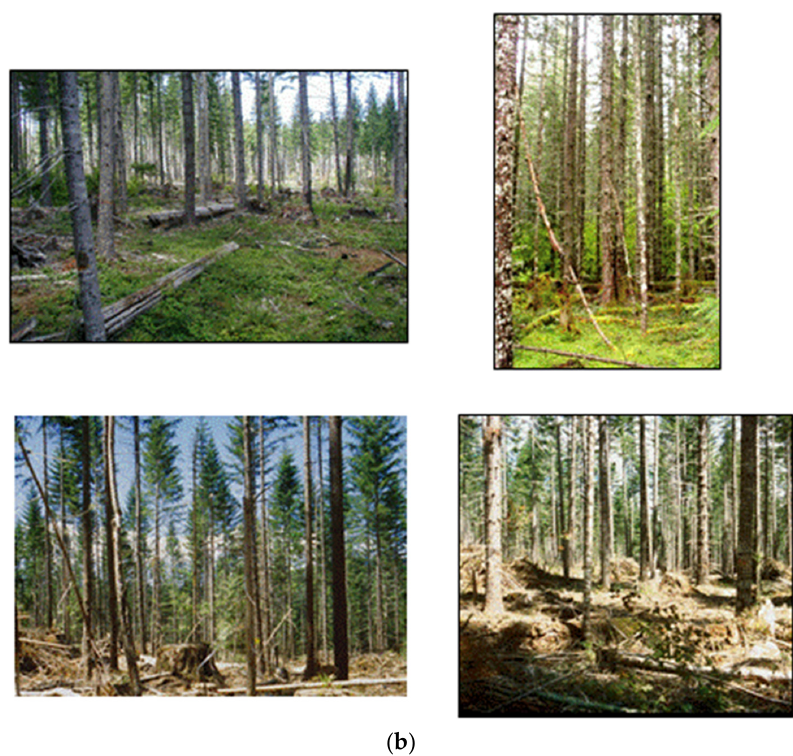
Figure 2. ( a ) Overview of one replication (Christi Flats) of the Young Stand Thinning and Diversity Study right after study installation. The control (upper right), light thin (lower right), light thin with gaps (upper left), and heavy thin (lower left) are surrounded by a blue, red, light green, and dark green line, respectively. Photocredit United States Department of Agriculture Forest Service; ( b ) Pictures highlighting treatments in the Young Stand Thinning and Diversity Study right after installation. Picture locations match 2a, i.e., the control is depicted in the upper right photo, light thin in the lower right, light thin with gaps in the upper left, and heavy thin in the lower left. Photo credit: United States Department of Agriculture Forest Service.